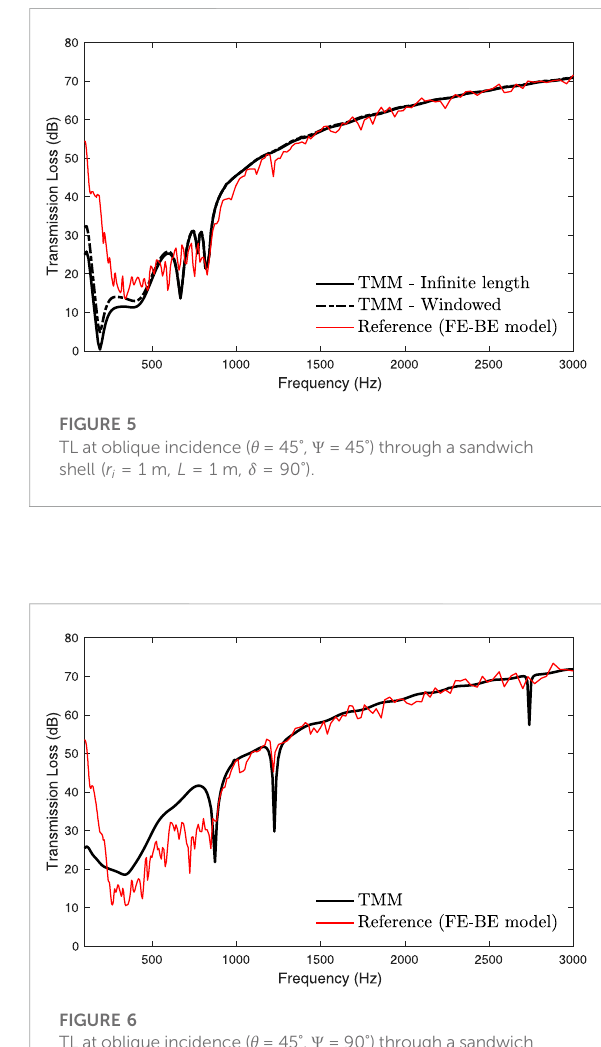
FIGURE 6 TL at oblique incidence ( θ = 45 ° , Ψ = 90 ° ) through a sandwich shell ( r i = 1 m, L = 1 m, δ = 90 °